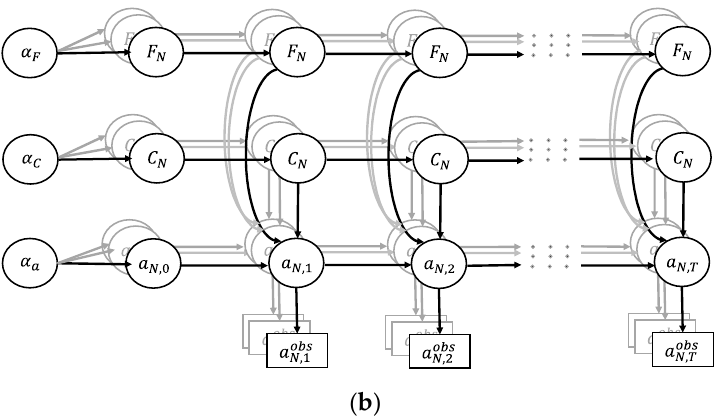
Figure 2. Schematic of established dynamic Bayesian network for FCP in OSD system. ( a ) General framework with time-dependent model uncertainty and material uncertainty. ( b ) Specific diagram with time-independent model uncertainty and material uncertainty in this study.